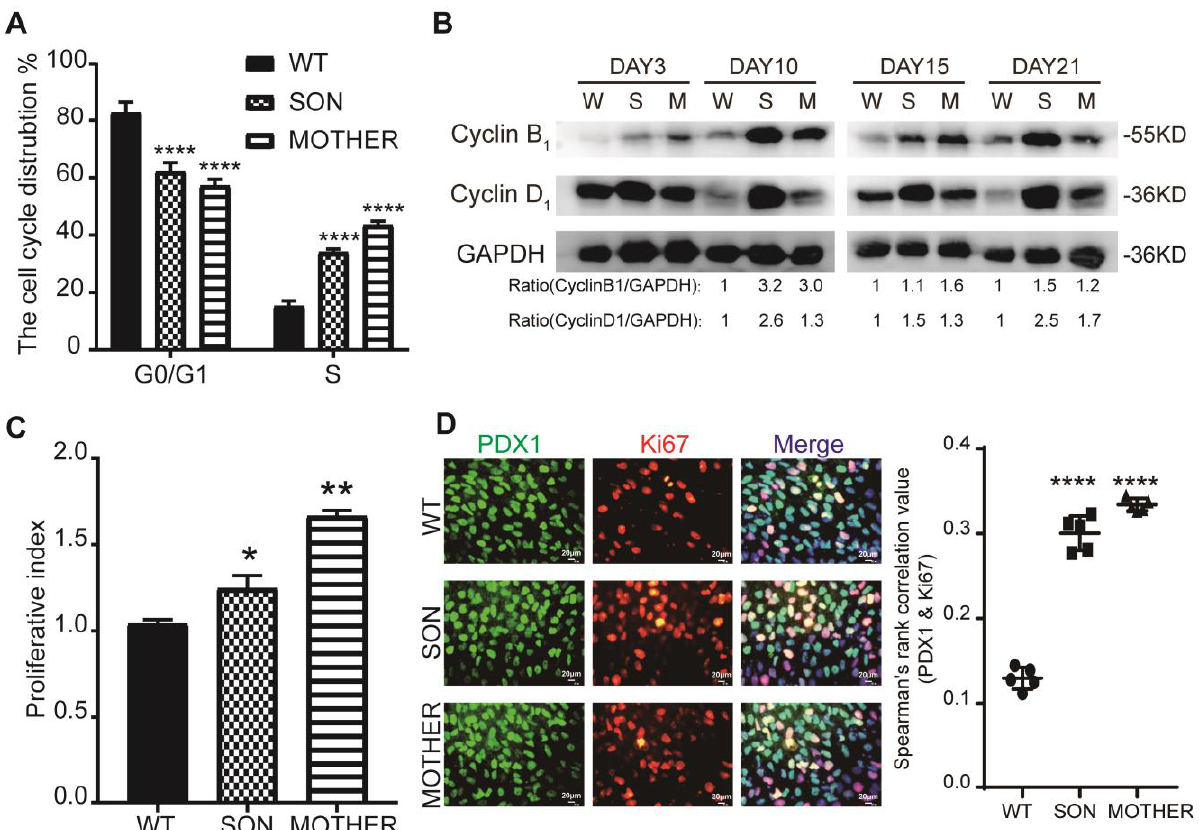
Figure 2. Increased insulin production in MEN1-IPCs was mainly linked with the proliferative abilities. ( A ) Cell cycle analysis by PI via flow cytometry in PPC stage, n = 3. ( B ) Cell cycle proteins, Cyclin D 1 and Cyclin B 1 were analyzed during the differentiation process from PPC stage to IPC stage, respectively, with the number below representing the fold change after being normalized n = 3. ( C ) Proliferative analysis by CFSE via flow cytometry since Day 7 – 13, n = 3. ( D ) The proliferation of PPC stage was identified by Ki67 and PDX1 with the doubled staining and quantitative information, and the correlation was calculated by image J, n = 5, scale bar: 150μm. W -WT, S-SON, M-MOTHER. The bar plots ( n ≥ 3 wells per group) are mean ± SEM. * p < 0.05, ** p < 0.01, and **** p < 0.0001.